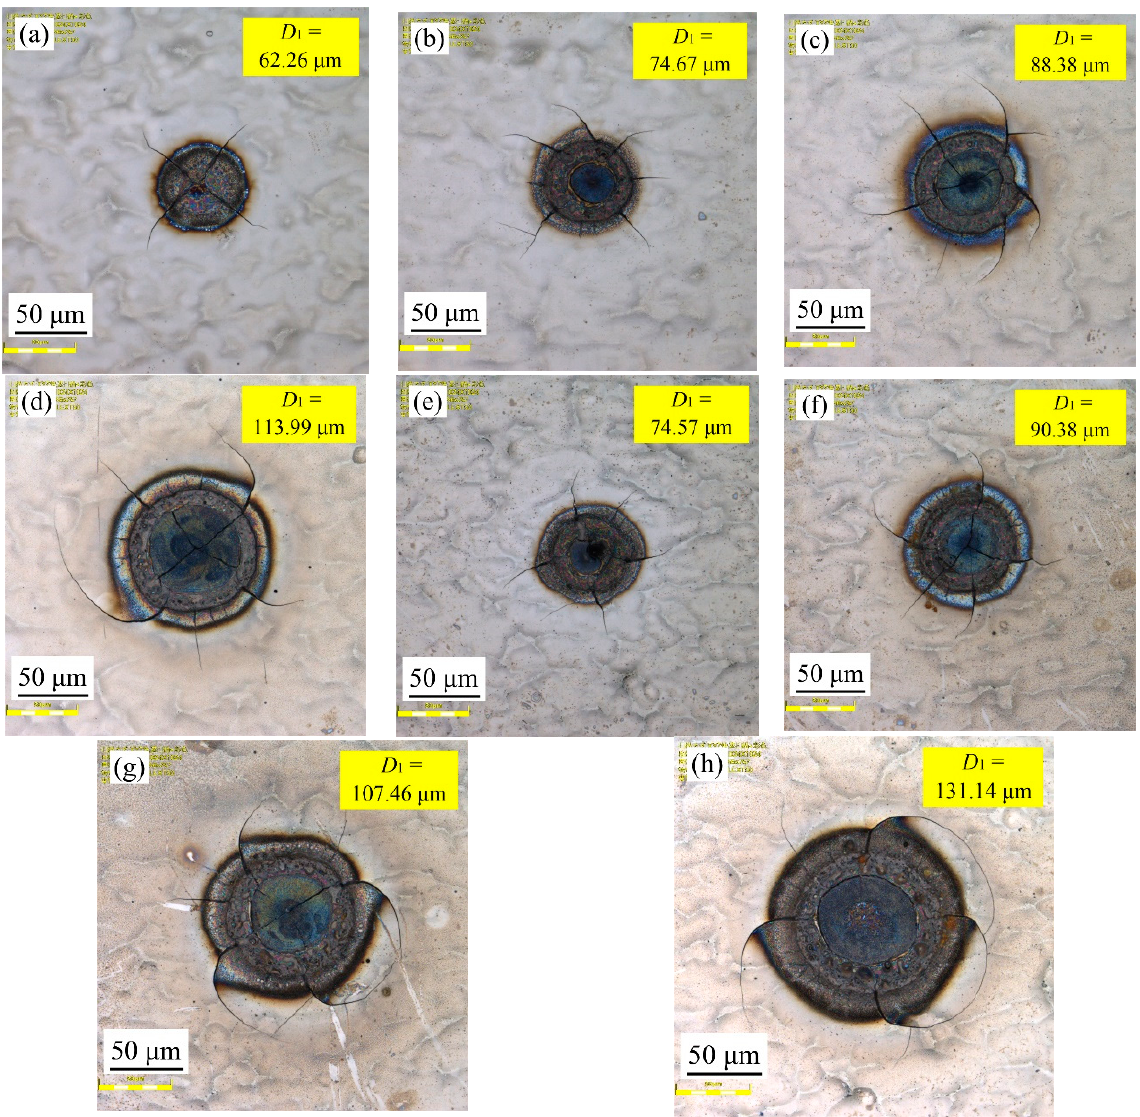
Figure 9. Effect of varying pulse width on samples’ surface morphologies: ( a ) 75 µs, 50 W; ( b ) 100 µs, 50 W; ( c ) 125 µs, 50 W; ( d ) 150 µs, 50 W; ( e ) 75 µs, 60 W; ( f ) 100 µs, 60 W; ( g ) 125 µs, 60 W; ( h ) 150 µs, 60 W.